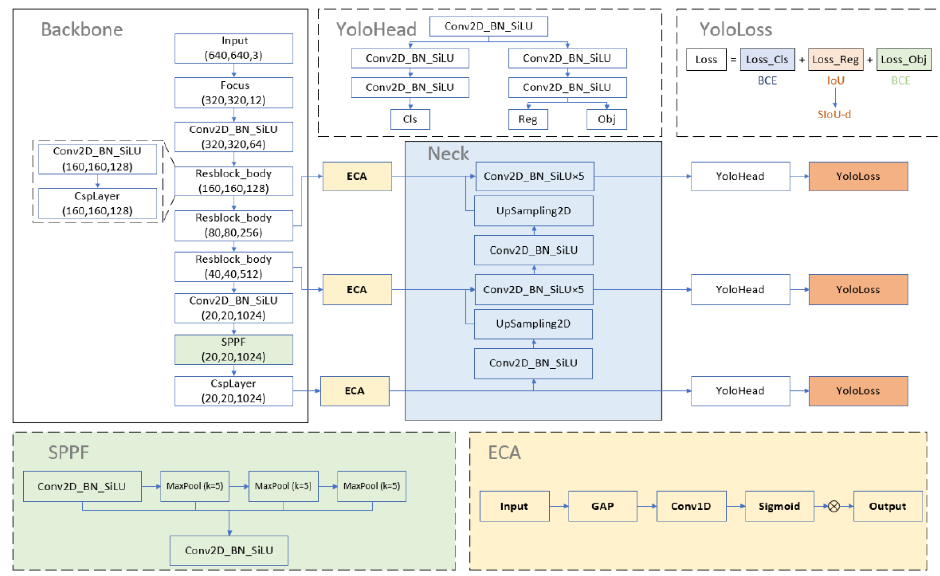
Figure 2. The structure of the improved model.